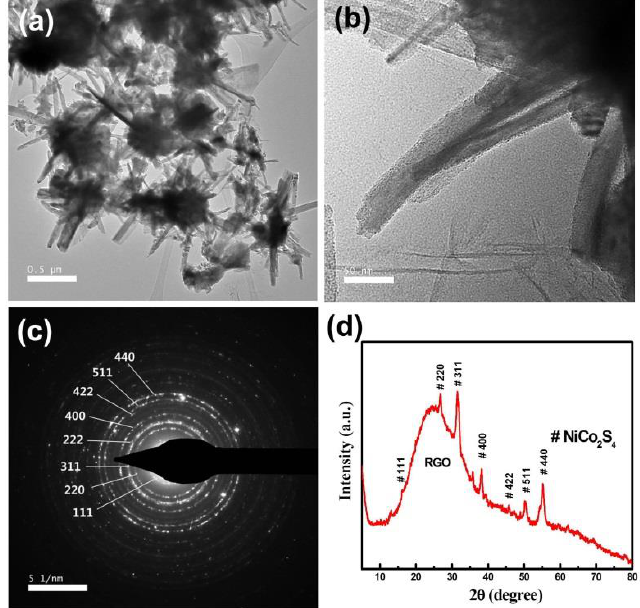
Figure 3. ( a ) Typical Transmission electron microscopic image of the NiCo 2 S 4 /Ni-rGO nanocomposites; ( b ) enlarged image of one branch; ( c ) SAED pattern of ( b ); ( d ) XRD pattern of the NiCo 2 S 4 /Ni-rGO nanocomposites.